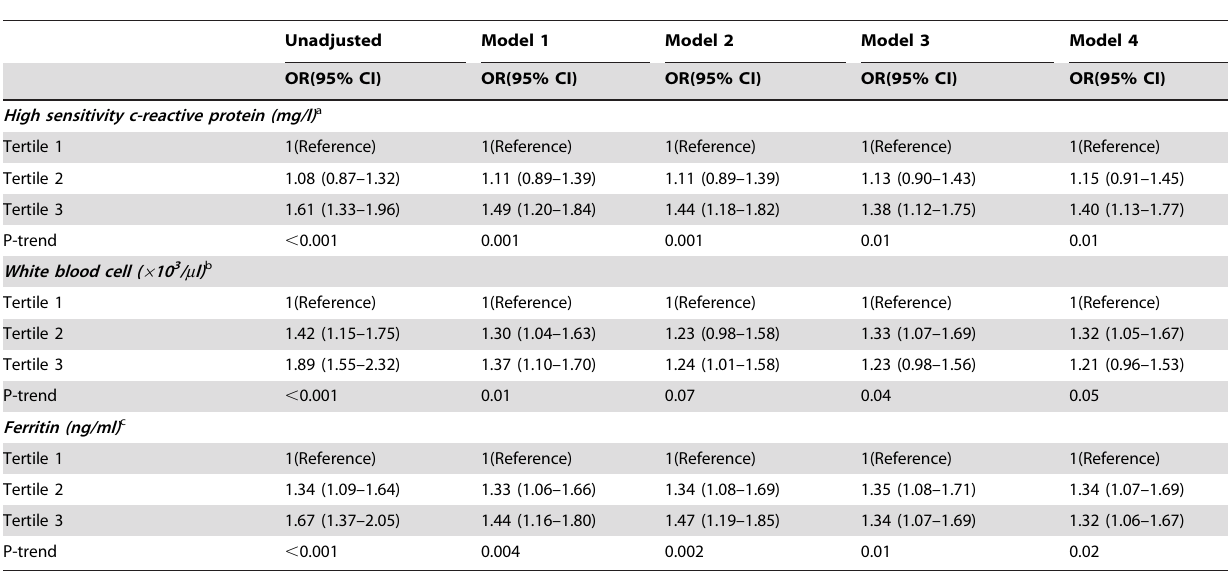
Table 5. Logistic regression analysis of risks for rapid progression of renal function among different inflammation markers